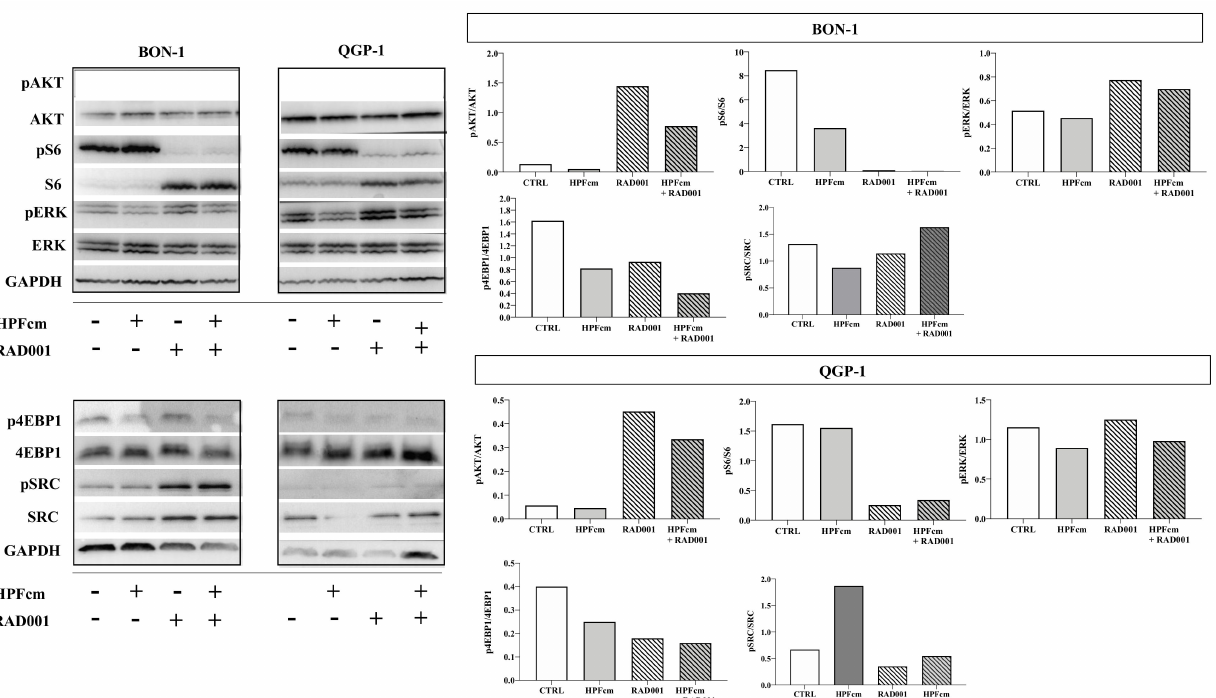
Figure 9. A representative Western blot showing phospho-AKT on Ser473 (pAKT) and total AKT, phospho-ERK1/2 on Thr202/Tyr204 (pERK) and total ERK1/2, phospho-S6 on Ser235/236 (pS6) and S6, phospho-4E-BP1 (p4EBP1) on Ser65 and total 4E-BP1, phospo-SRC on Tyr416 (pSRC) and total SRC and GAPDH performed in BON-1 and QGP-1 cells after incubation with HPFcm and with or without RAD001 at 1 nM and 5 nM, respectively, in comparison to untreated cells. Incubation with RAD001 decreased phosphorylation of S6 in both cell